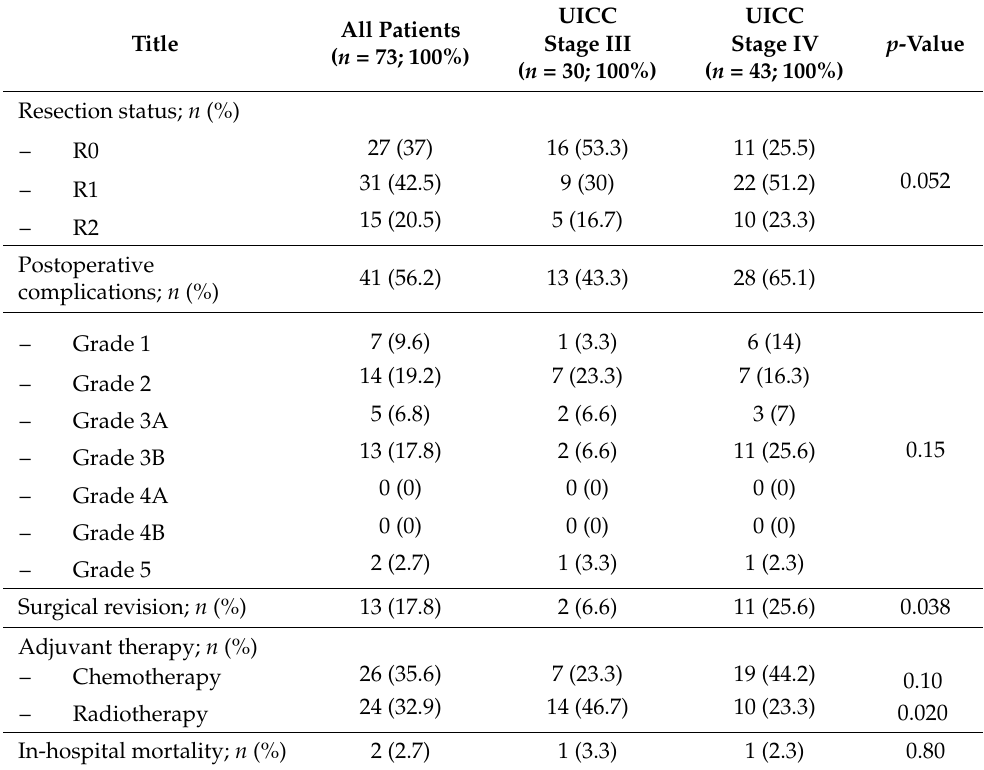
Table 2. Postoperative data.